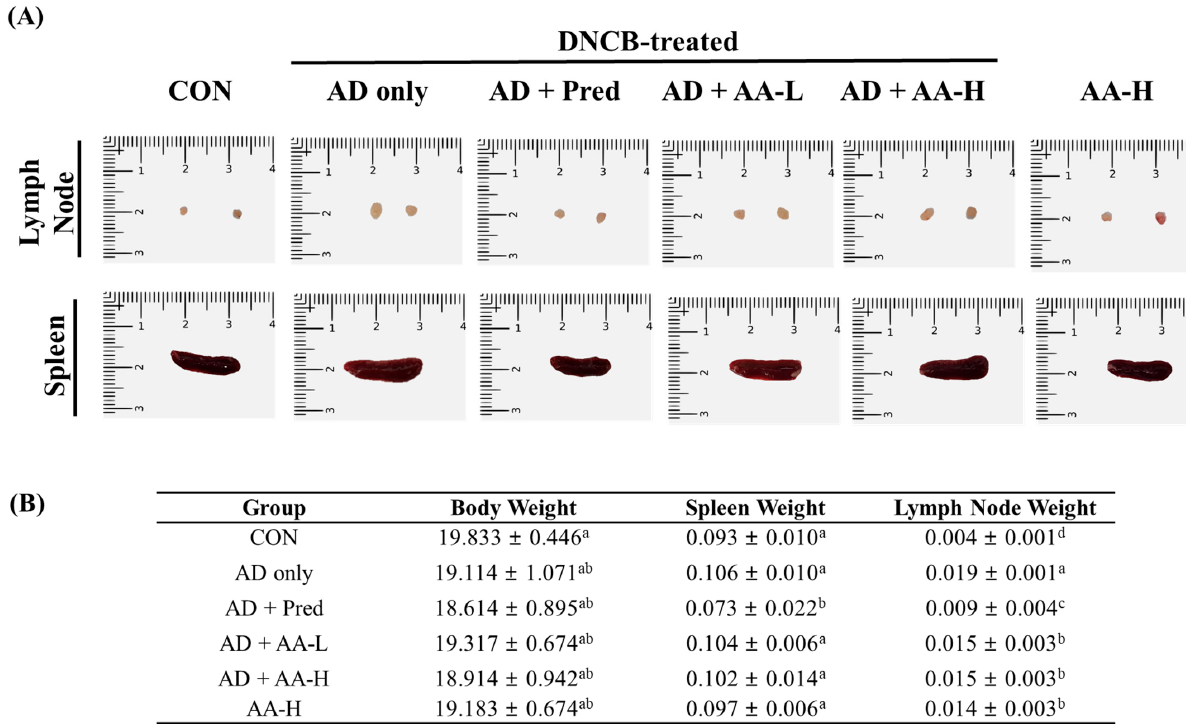
Figure 4. Effect of asiatic acid (AA) on immune organs in the atopic dermatitis (AD) animal model. ( A ) The lymph nodes and spleens of the AD mice were photographed on day 18 after treatment. ( B ) Descriptive statistics showing differences in body, lymph node, and spleen weights in each group. The significant values according to Duncan’s multiple range test ( p < 0.05) are indicated by different letters, and values are expressed as the mean ± standard deviation ( n = 7 per group). CON, control group; AD only, mice sensitized with 0.25% 2,4-dinitrochlorobenzene (DNCB) in 200 µL of 3:1 acetone/bean oil; AD + AA-L and AD + AA-H, 30 and 75 mg/kg AA-treated DNCB-sensitized mice, respectively, in 100 µL of sterilized drinking water; AA-H, mice orally administered 75 mg/kg AA; AD + Pred, positive control mice treated with 5 mg/kg prednisolone in 100 µL of sterilized drinking water.